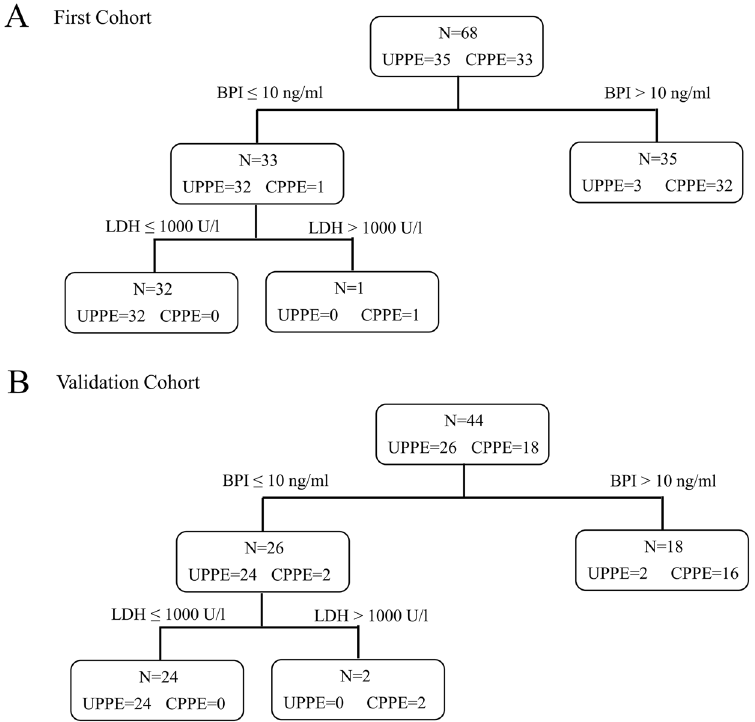
Figure 3. The diagnostic power of the pleural fluid BPI levels combined with LDH levels for identifying complicated parapneumonic effusions. A decision tree for CPPE and UPPE discrimination in the first cohort ( A ) and in the validation cohort ( B ). In the first cohort, the sensitivity and specificity of the combination of the pleural fluid BPI levels and LDH levels were 100% and 91.4%, respectively. In the second cohort, the sensitivity and specificity of the combination of the pleural fluid BPI levels and LDH levels were 100% and 92.3%,